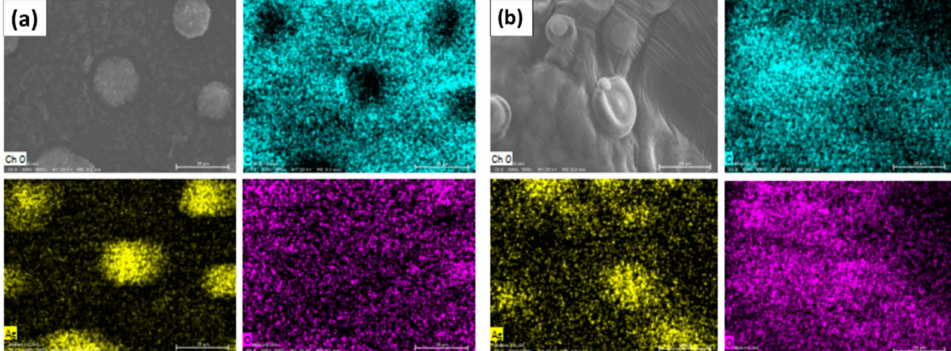
Figure 3. Chemical mapping of the elements carbon (blue color), silver (yellow color) and oxygen (purple color), ( a ) AgNPs-PE and ( b )